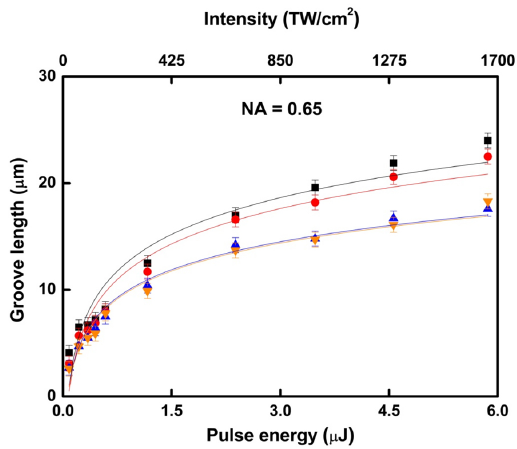
Figure 4. Groove width as a function of the pulse energy for the borosilicate glass (NA = 0.65). The symbols represent the experimental results for four scan speeds: ( ) 50, ( ) 100, ( ) 500 and ( ) 1000 μm/s. Solid lines are the fitting obtained with Equation 1.